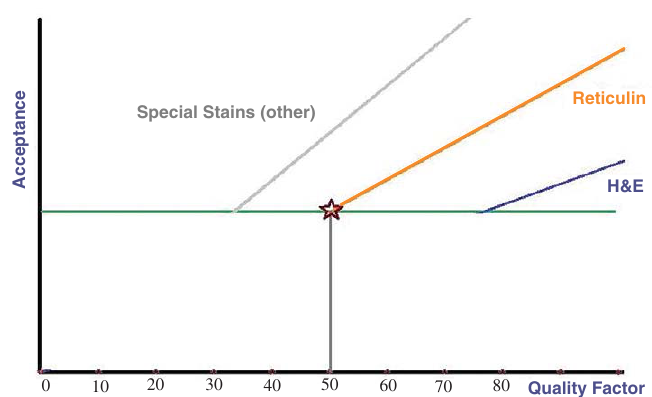
Fig. 6. (Acceptable QF Values for HE, Reticulin and other special stains).